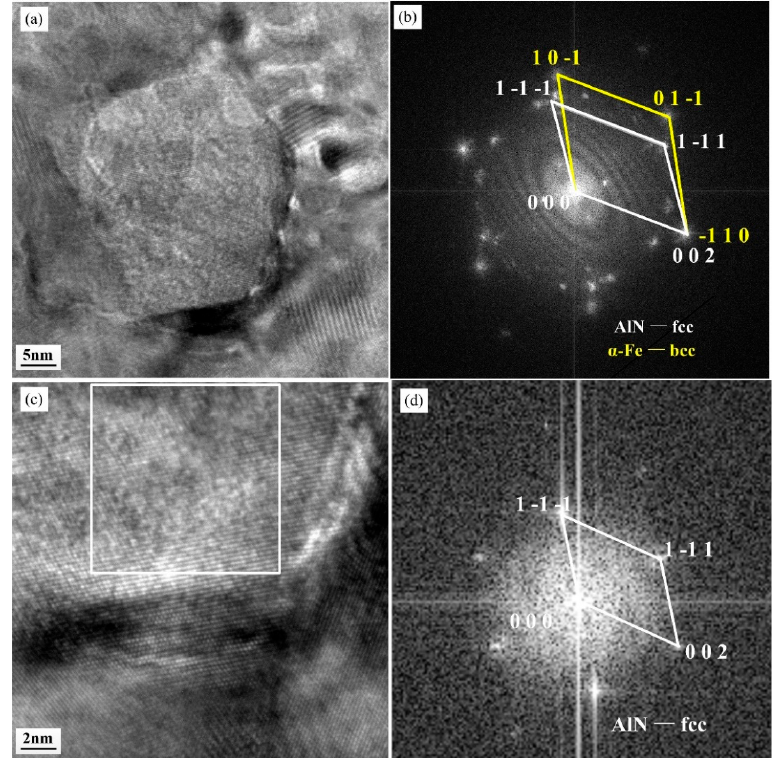
Figure 3. HR-TEM micrograph of the precipitate ( a ) and the corresponding FFT diffractogram ( b ) in the intermediate sheet annealed at 1000 °C for 15 min; ( c ) the magnified micrograph of precipitate, and ( d ) the FFT diffractogram of the white square zone.